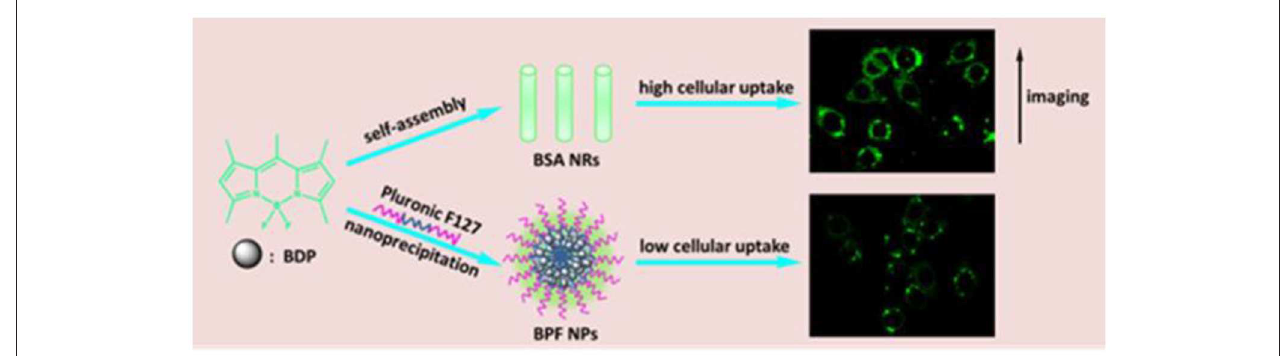
FIGURE 1 | Size distribution of (A) BPF NPs and (B) BSA NRs measured by DLS in aqueous solution. Insets: TEM image and CLSM image of BPF NPs or BSA NRs. Scale bars in all TEM images are 200nm. Scale bars in all CLSM images are 500nm. (C) UV-vis absorption spectra of BDP or Pluronic F127 in acetone and BPF NPs or BSA NRs in aqueous solution, respectively. (D) Photos of BDP, BPF NPs, and BSA NRs in room light field and under 365nm light irradiation, respectively. (E) Fluorescence spectra of BDP, BPF NPs, and BSA NRs, respectively. (F) Time-resolved decay profiles of BDP, BPF NPs, and BSA NRs, respectively.